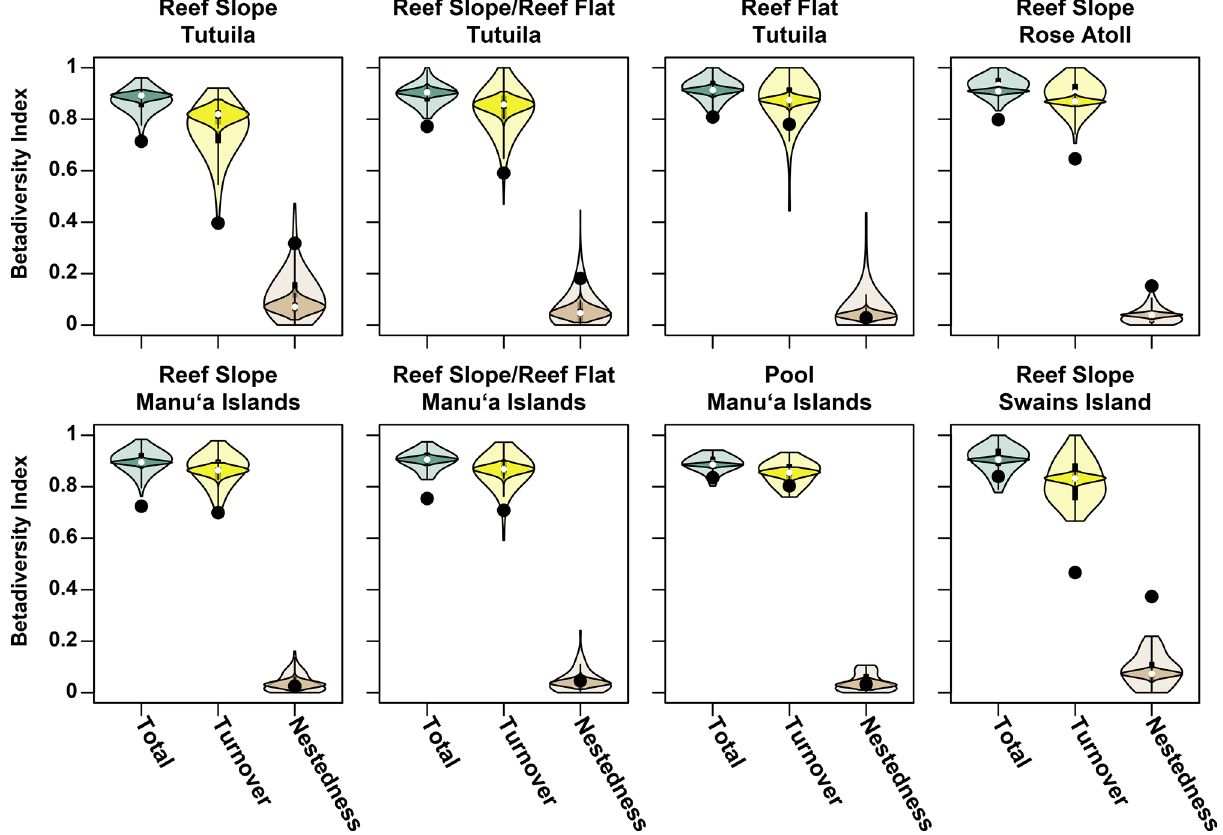
Figure 6. Beta diversity estimates using pairwise site comparison between the MCE and individual SCR habitat groups. Black points represent the beta diversity for the single pairwise comparison, the light-colored areas represent the beta diversity calculated with the bootstrapped pairwise comparison from each group, and the dark colored areas represent the bootstrapped multiwise comparison from each